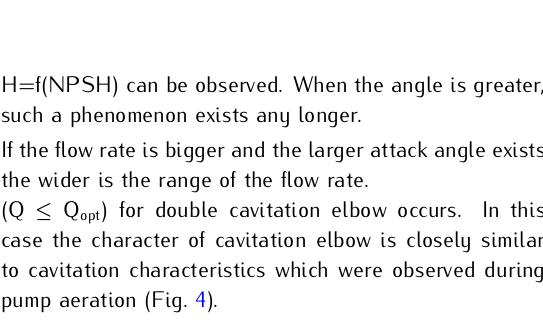
efficiency - Table 1 (attack angle for these case has